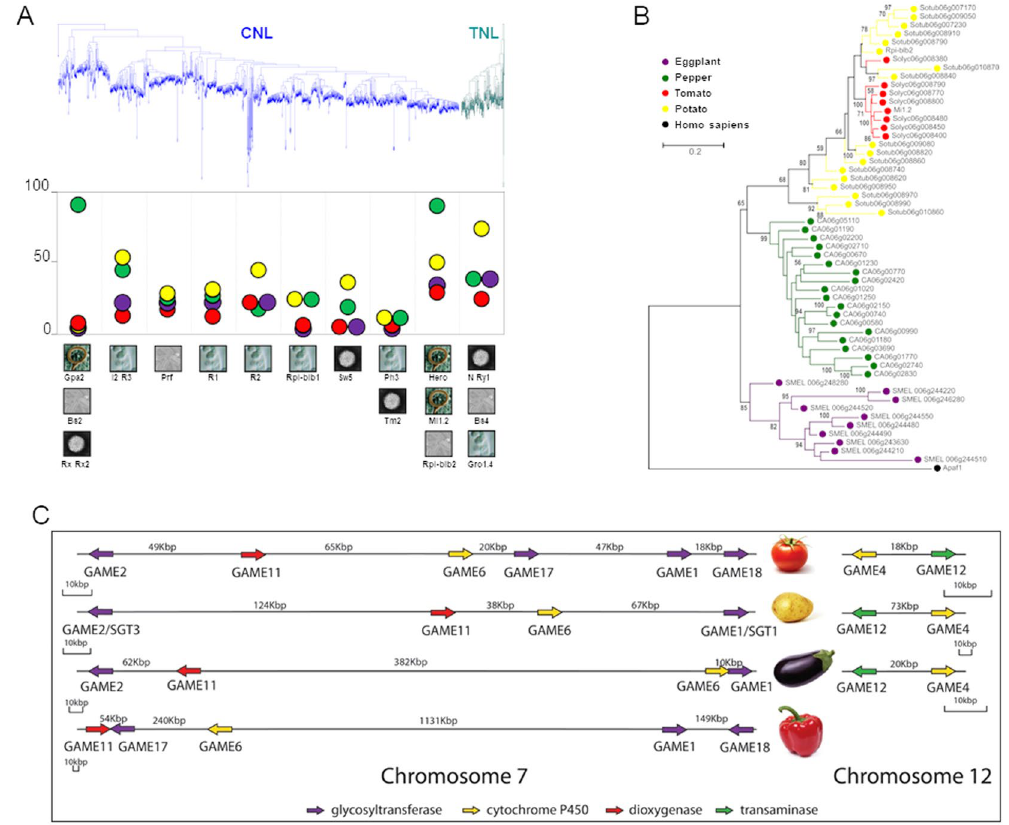
Figure 6. Gene family evolution in the Solanaceae. ( A ) Phylogenetic tree of CNL (in blue) and TNL (in green) NB-LRR genes. The distinctive evolutionary dynamics of ten NB-LRR groups in eggplant (purple), potato (yellow), tomato (red) and pepper (green) genomes are displayed. The number of NB-LRR genes included in each group is indicated on the vertical axis. The plant pathogens (fungi, virus, bacteria or nematodes) to which known genes in the clade confer resistance are indicated by pictures. Gro1 . 4 and Hero confer resistance to Globodera rostochiensis . Gpa2 and Mi1 . 2 confer resistance to Globodera pallida and Meloidogyne incognita , respectively. Rx and Rx2 confer resistance to Potato Virus X . N , Ry1 , Tm2 and Sw5 confer resistance to Tobacco Mosaic Virus, Potato Virus Y, Tomato Mosaic Virus and Tomato Spotted Wilt Virus, respectively. Bs2 and Bs4 confer resistance to Xanthomonas campestris and Prf to Pseudomonas syringae . Rpi-blb1 , Rpi-blb2 , R1 , R2 and R3 confer resistance to Phytophthora infestans and I2 to Fusarium oxysporum . ( B ) Independent